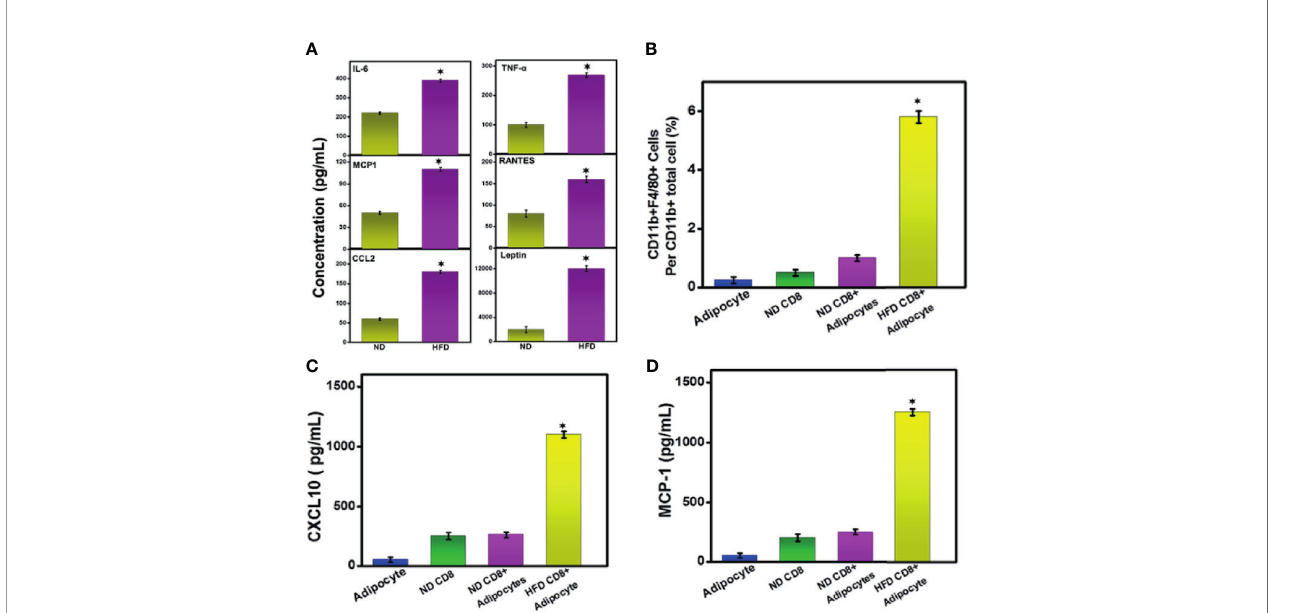
FIGURE 8 | DIO increases the secretion of leptin and systemic cytokines into the serum. HFD induction modulates in fl ammatory cytokines . (A) HFD induces systemic IL-6, MCP-1, IL-1 b , TNF- a , RANTES, and leptin at the experimental endpoint after 16 weeks from the groups of mice analyzed by ELISA assay. (B) in vitro effect of CD8 + T cells and adipocyte on differentiation of circulating CD11b +high monocytes. HFD and ND induced CD8 + T cells and adipocytes were isolated and puri fi ed from epididymal AT. We co-cultured CD8 + T cells and adipocytes with circulating monocyte with various combinations. The differentiated macrophage numbers are shown. (C, D) Concentrations of CXCL10 and MCP-1 in the culture supernatant are shown. The cumulative data represent the concentration of in fl ammatory cytokine and chemokines ± SEM from three independent experiments. *p < 0.01, unpaired student ’ s t-test indicates statistically signi fi cant differences in cytokine levels and the number of macrophages between ND and HFD